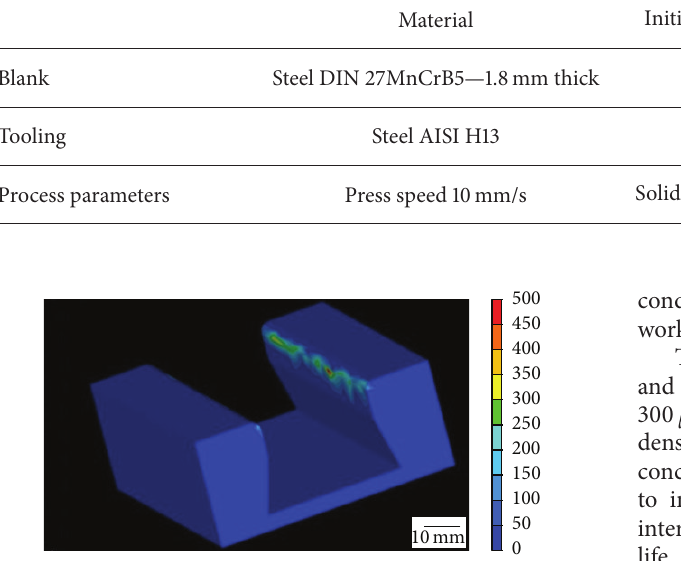
Figure 4: Die wear in MPa ⋅ mm—numerical